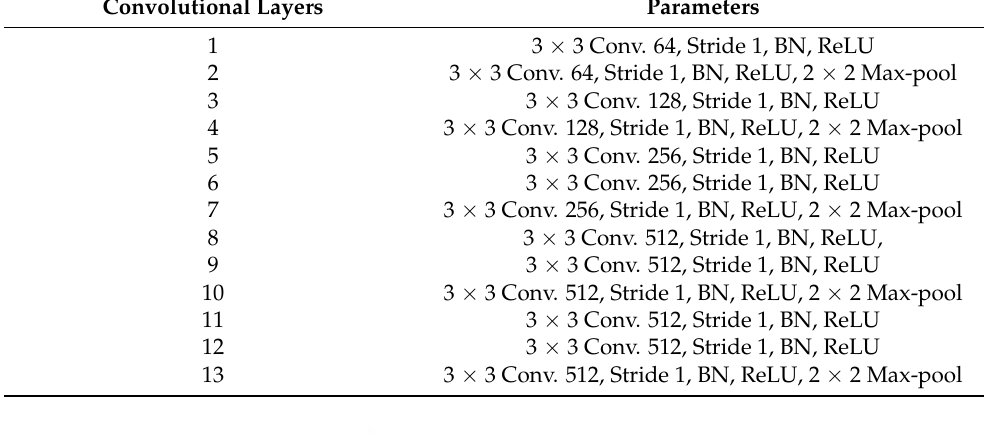
Table 2. Characteristics of Vgg16 to classify rapeseed crop in terms of health.